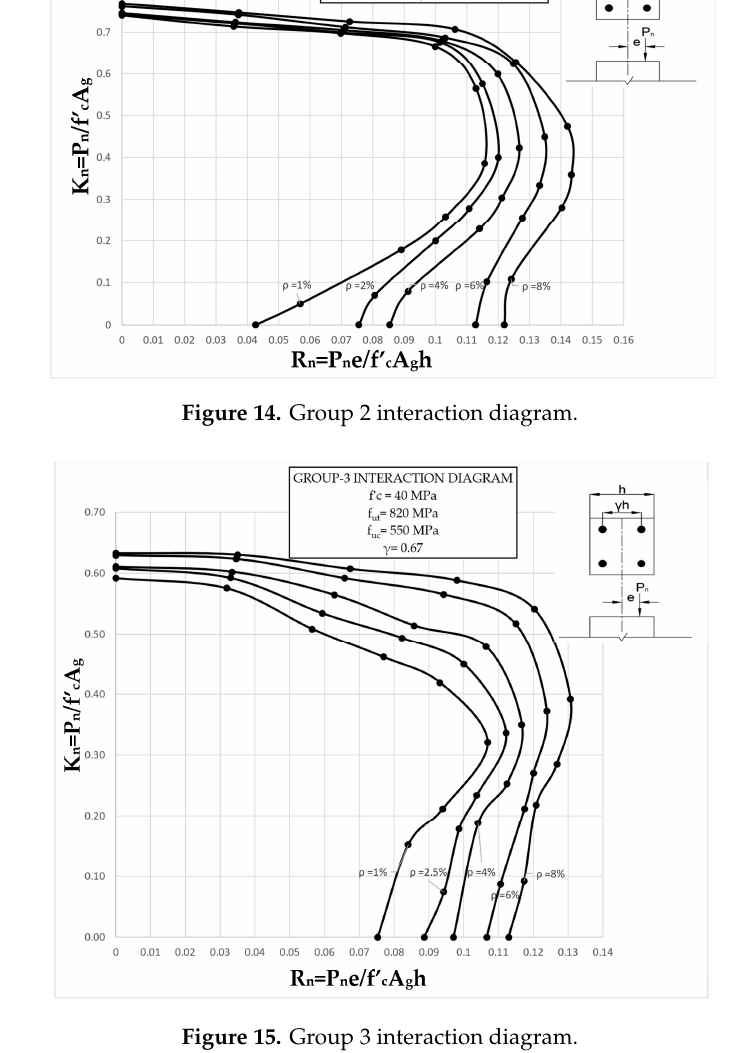
Figure 15. Group 3 interaction diagram.